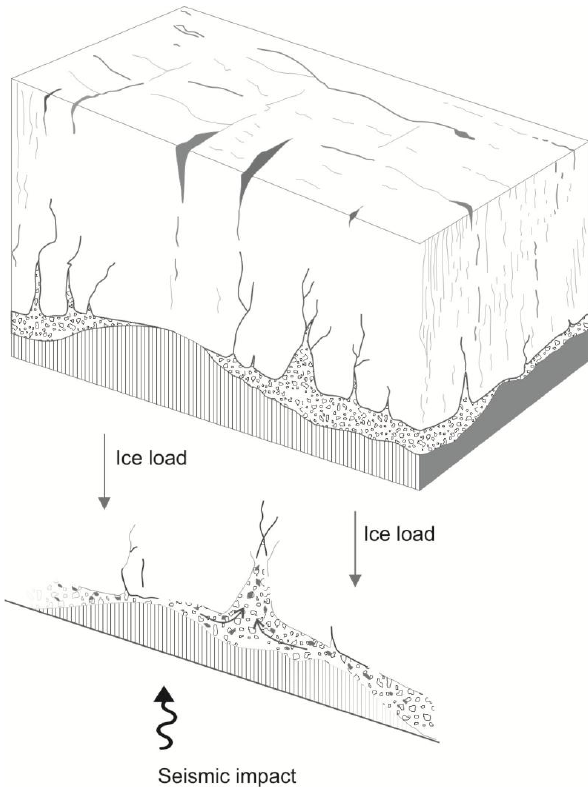
Figure 6. Diagram illustrating the proposed mechanism forming the ridges in the Maskevarri Ráhppát. Adopted from Hoppe